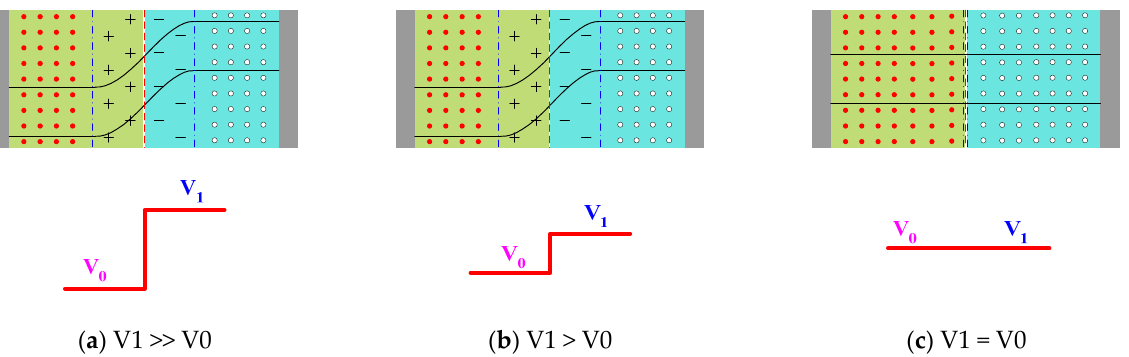
Figure 4. Schematic diagram of the PN junction barrier in APD changing when the light intensity increases.